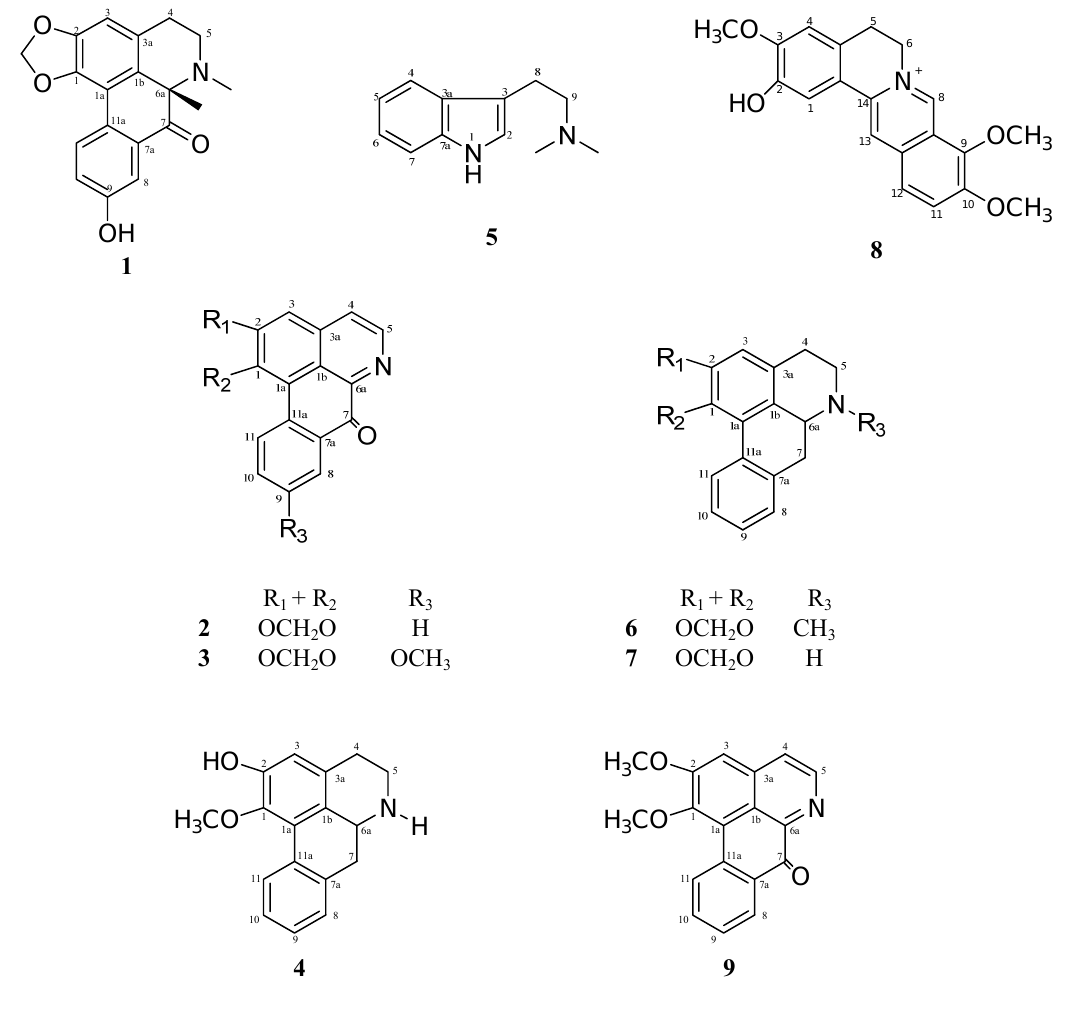
Figure 1. Alkaloids 1 - 9 , isolated from Fissistigma